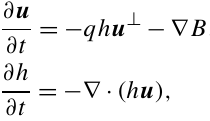
, ε = π and µ = 0 . 45 12